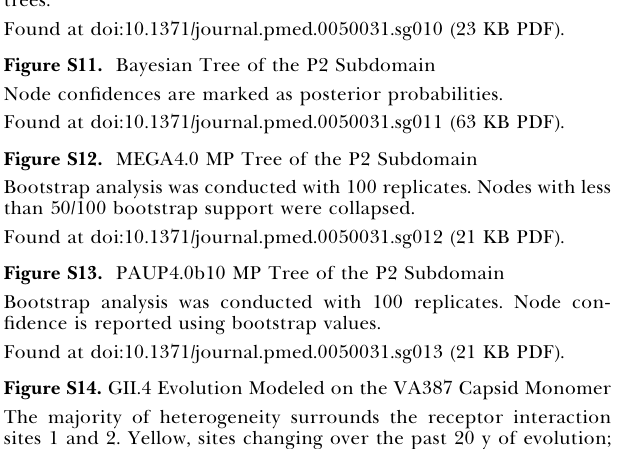
Figure S15. Electron Micrograph of GII.4 VLPs Purified GII.4 ORF2 VLPs were visualized by negative stain EM. Found at doi:10.1371/journal.pmed.0050031.sg015 (1.8 MB PDF). Figure S16. Biosynthetic Pathway of Histo-Blood Group Antigens HBGA of the intestinal tract are produced by the successive addition of carbohydrate moieties onto core precursor chains of type 1 and type 3 (A), and type 2 core chain (B). Figure S17. GII.4 VLP-Carbohydrate Binding Patterns at 37 8 C VLPs were assayed for ability to bind to synthetic biotinylated HBGAs bound to avidin-coated plates. The mean optical density is indicated by the line in the box. The upper and lower boundaries of the box represent the maximum and minimum values. (A) VLP binding to core chains including an a -1,2-fucose. (B) VLP binding to either core chains or H antigens modified with the Lewis antigen. (C) VLP binding to A- or B-antigen trimer. Figure S18. Murine Antisera Blockade of GII.4 VLP Binding to HBGAs Antisera collected from mice immunized against each GII.4 ORF2 were assayed for blockade of GII.4–1987-H type 3 (A), GII.4–1997-H type 3 (B), GII.4–2002-Le y (C), and GII.4–2002a-Le a (D) interaction and the mean percentage of control binding calculated compared to the no-serum control binding. Table S1. 176 Norovirus ORF2 Sequences Used in This Study Accession numbers beginning with EU are newly sequenced strains received from CDC. Table S2. Identification of Informative Sites Table S3. GII.4 Sequences Used in This